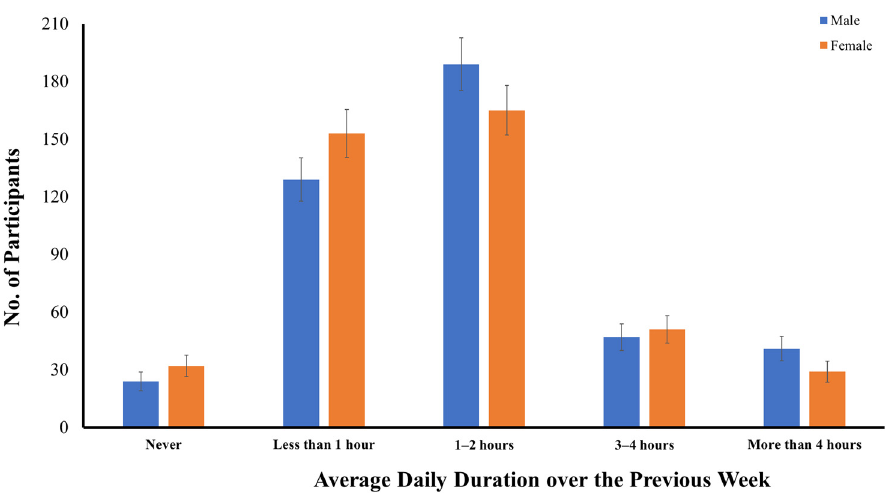
Figure 3. Distribution of early adolescents categorized across gender based on their average daily time spent watching television over the previous week.